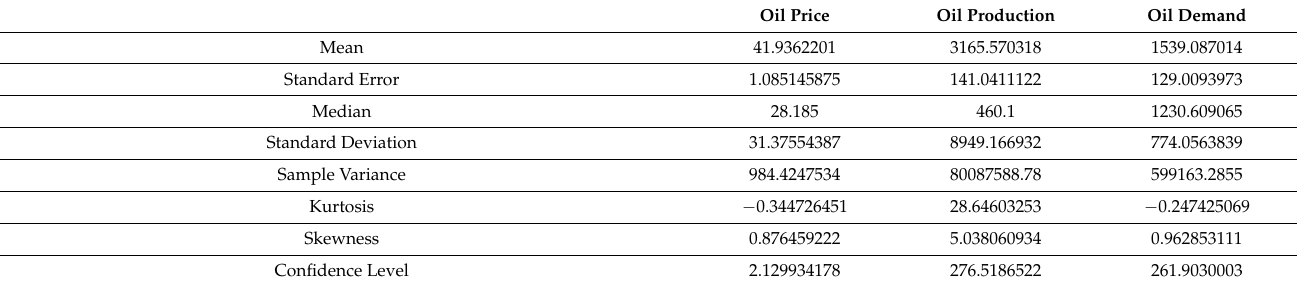
Table 3 describes a number of statistical metrics such as mean, standard error, median, standard deviation, etc., of the three datasets oil price, oil production, and oil demand. For